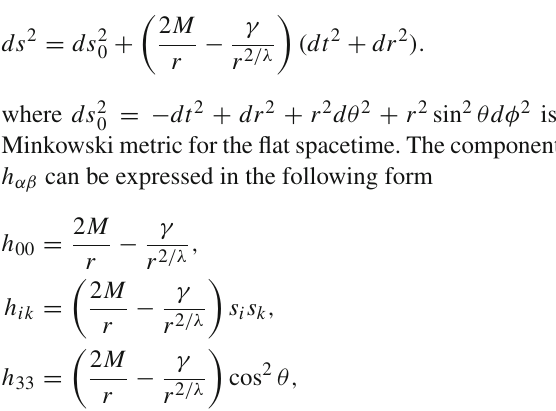
Fig. 9 The radius of KR BH shadow depends on KR parameters γ (up panel) and λ (down panel). Where M =